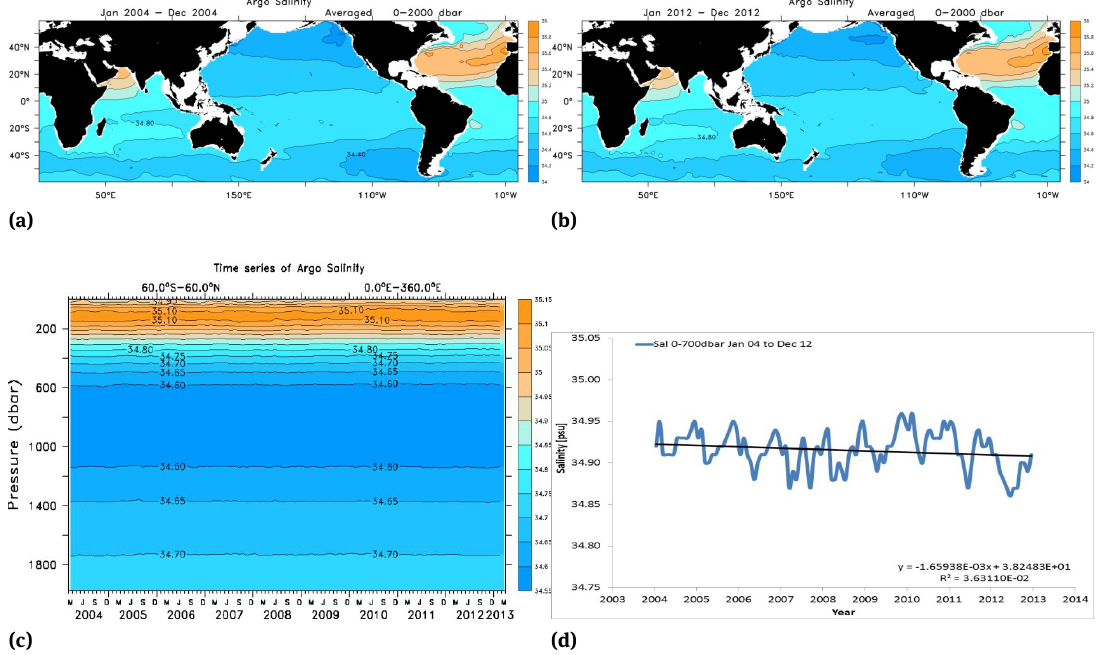
Fig. 3. a,b: yearly averaged constant salinity lines over the years 2004 and 2012 in the layer 0 – 2000 meters; c: salinity time series March 2004 to March 2013; d: trend line for salinity in the layer 0 – 700 m. Figures are obtained by using the ARGO Global Marine Atlas (from ARGO